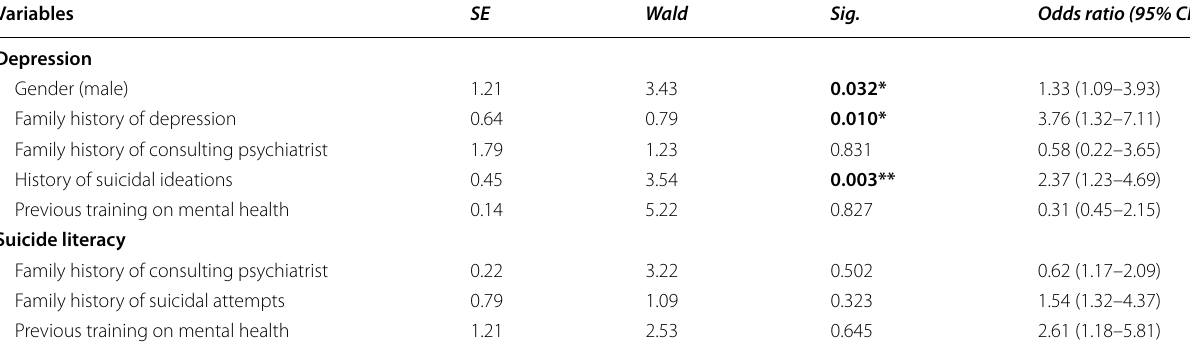
Table 6 Binary logistic regression analysis showing the most important predictors of depression and suicide literacy